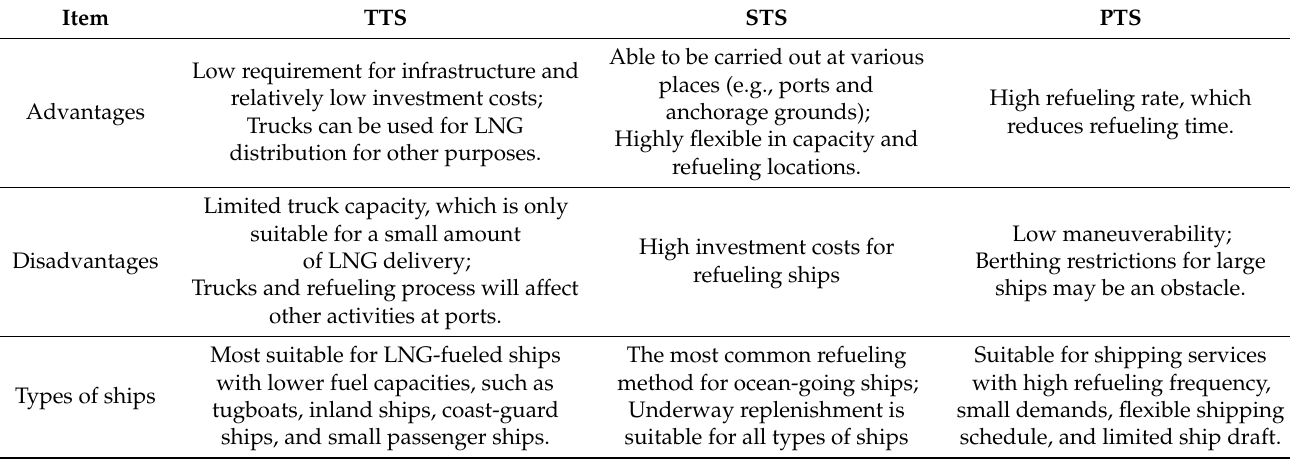
Table 4. Advantages and disadvantages of three methods to refuel LNG-fueled